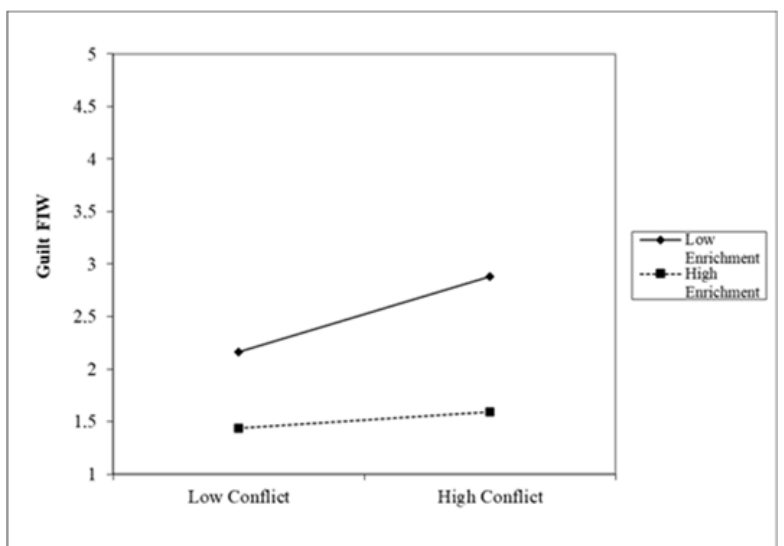
Figure 2. Moderating effect on Guilt FIW